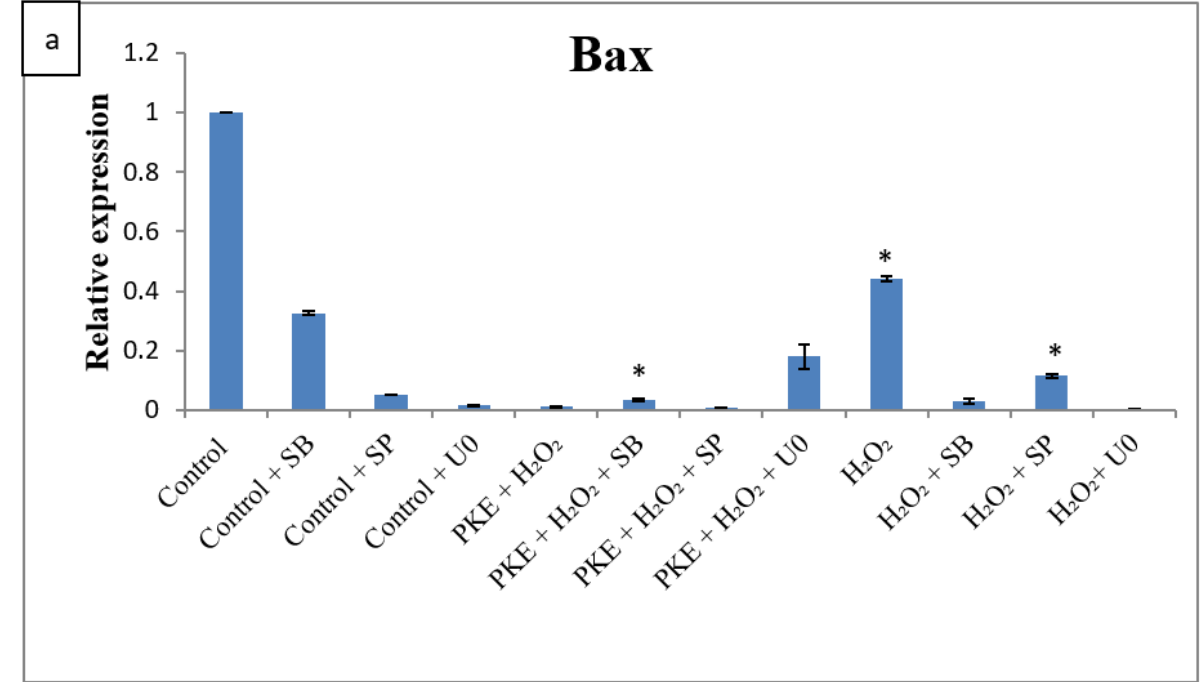
U0126-MKK, and SP600125-JNK, and the expressions of Bcl-2 and SOD-2 were upregulated.